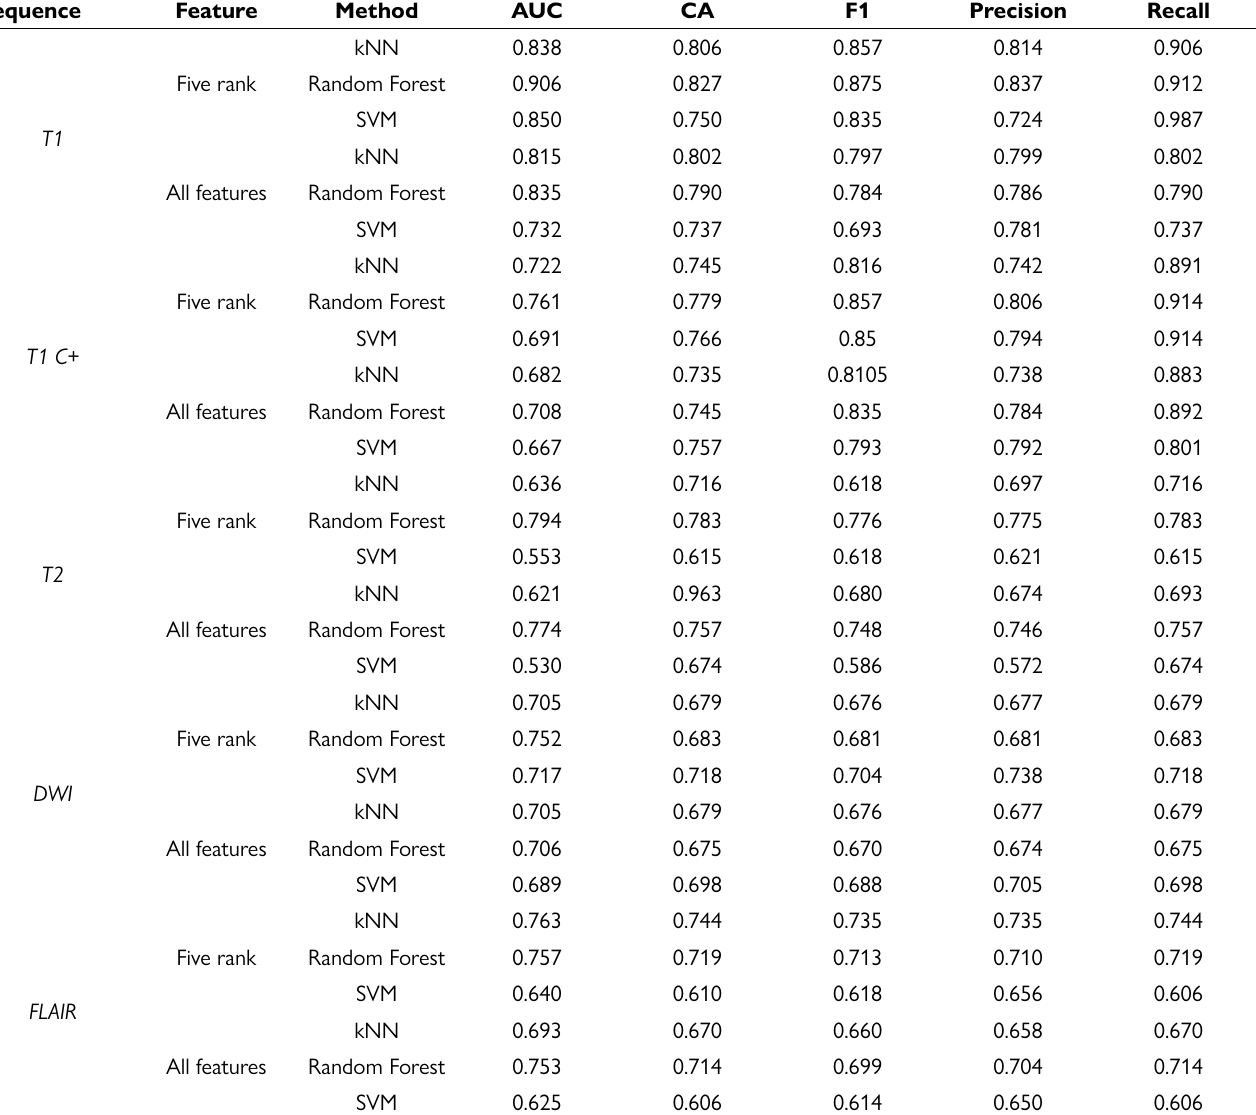
Table 4. Area under the ROC curve (AUC), CA, F1, precision and recall from all three ML methods (kNN, Random Forest and SVM) performed in the two forms of data analysis (five rank and all features) on T1-weighted, T1-weighted with contrast, T2-weighted, DWI and FLAIR images.